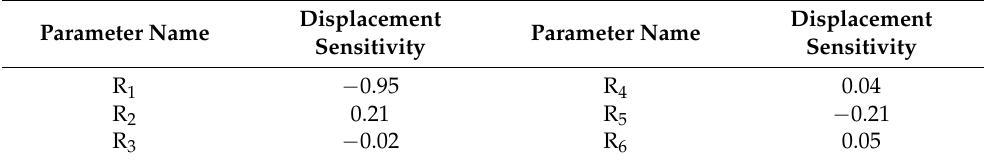
Table 3. Sensitivity of displacement to plate